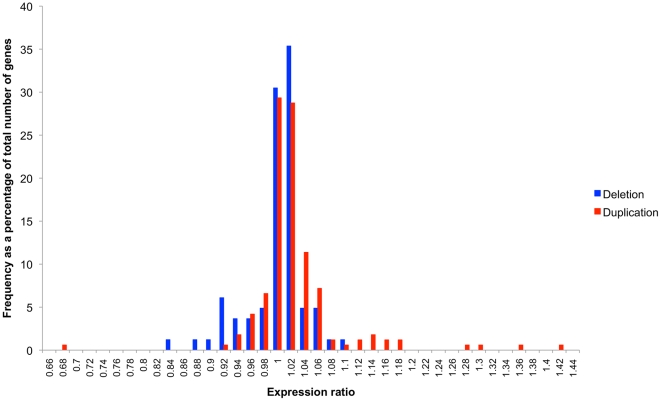
Frequency distribution graphs of expression ratios.Expression ratio distribution for the same individuals and the same expression data as analysed by Schuster-Böckler et al.
[4]. Only type I genes based on the CNV coordinates from Conrad et. al. [1] were used.